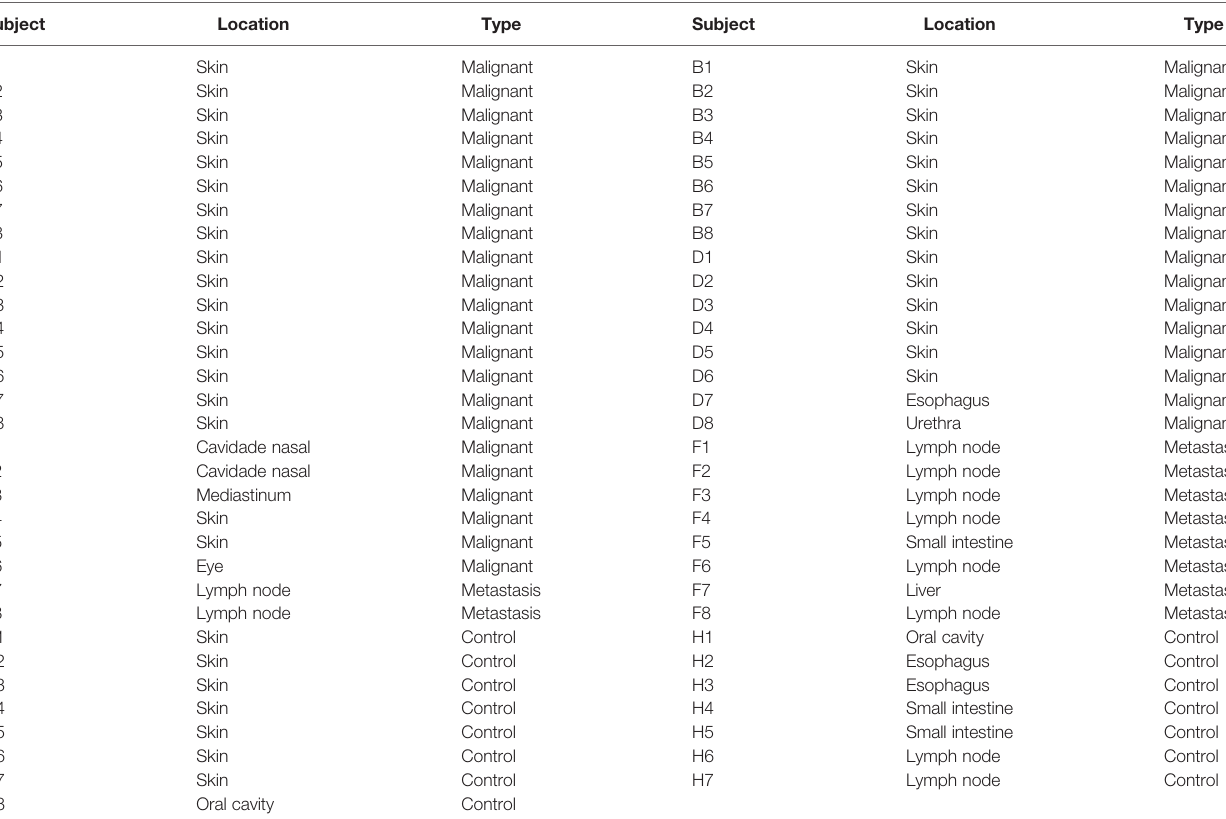
TABLE 1 | Clinical – pathological information and TNM staging of human melanoma specimens ( n = 63) used in this